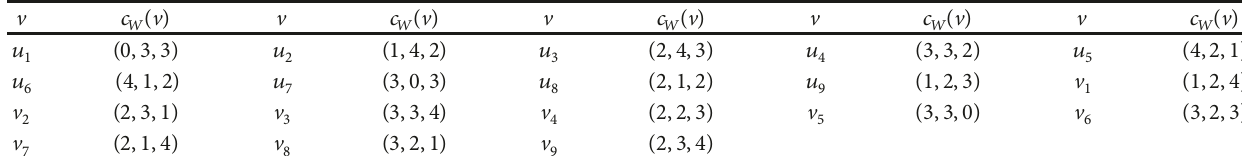
Table 1: The code 𝑐 𝑊 ( V ) of V with respect to 𝑊 = {𝑢 1 ,𝑢 7 , V 5 } in 𝑃(9,3)